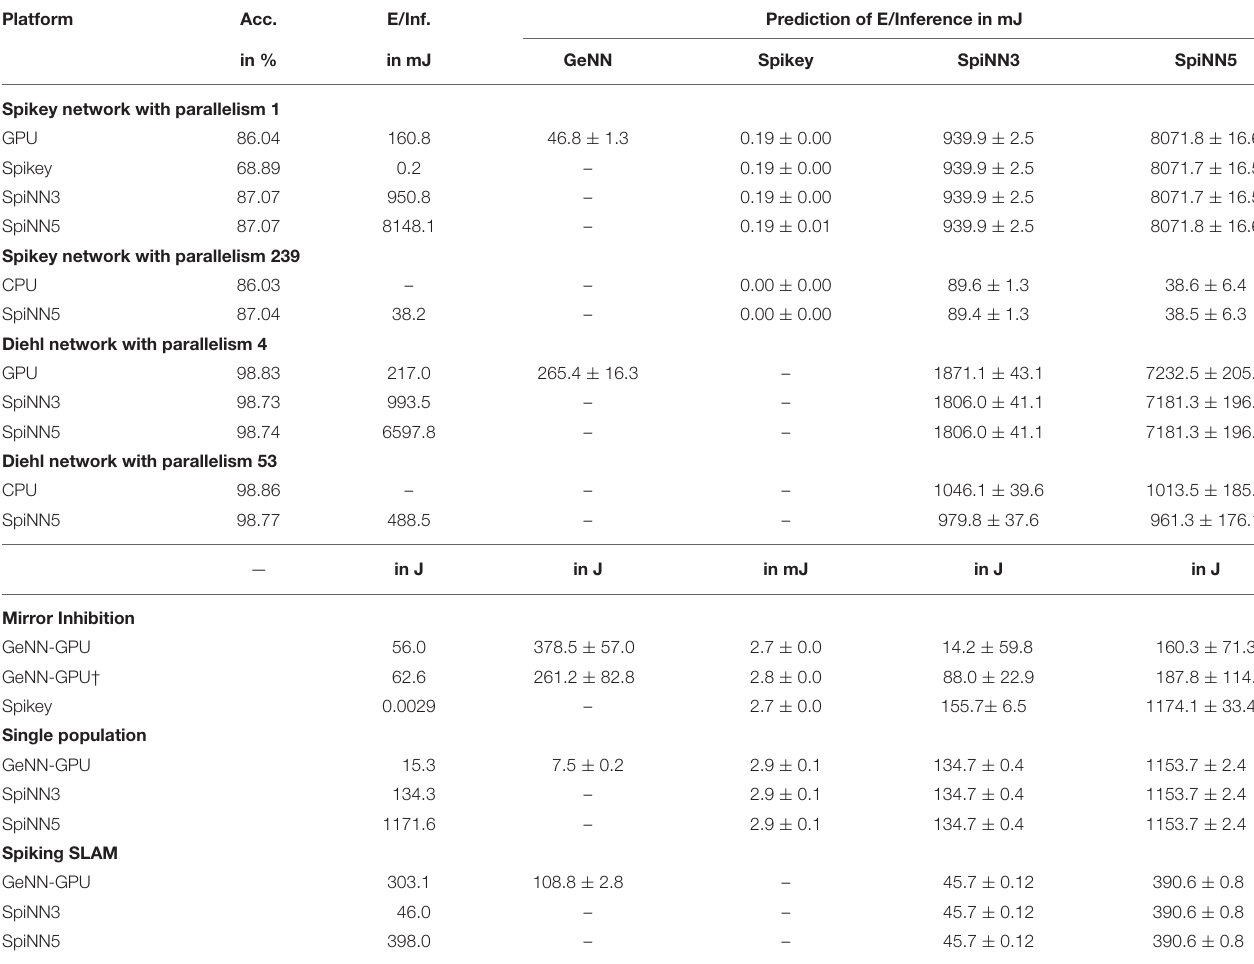
TABLE 6 | Validation of the energy model. Platform